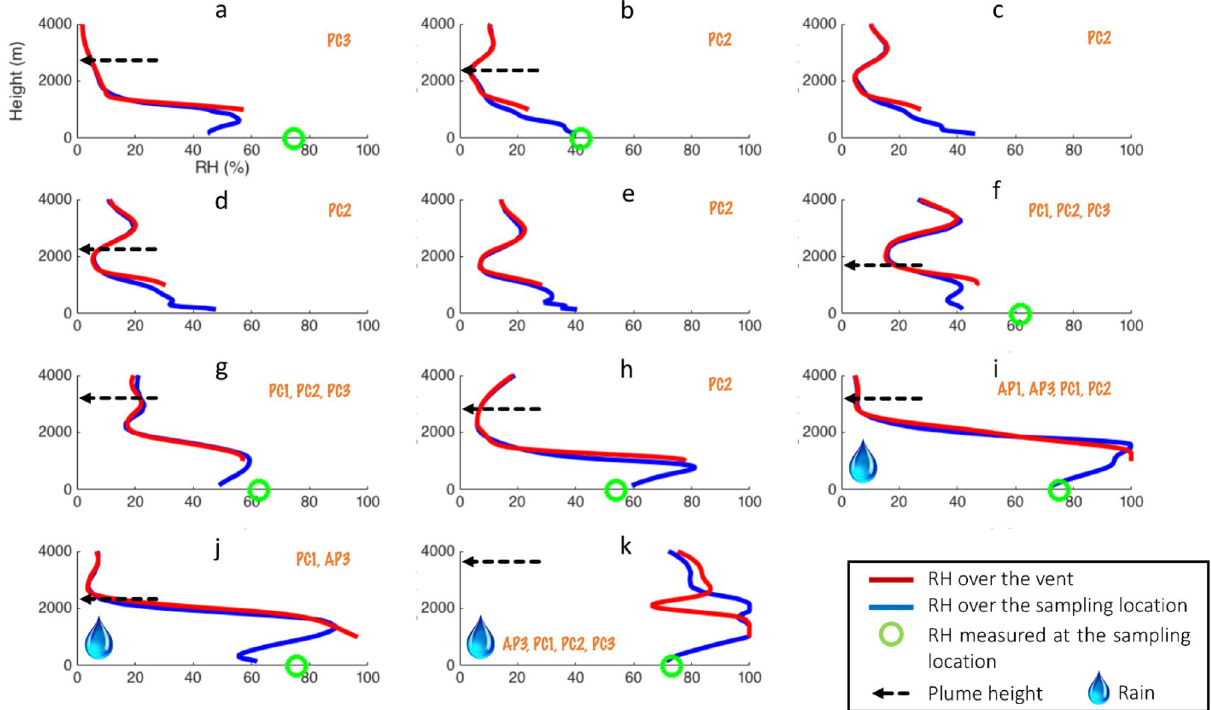
Figure 6. Modelled relative humidity profiles above the vent and above the sampling locations for all the eruptions obtained using the Weather Research and Forecasting (WRF) model. The green dot is the actual value measured using the portable meteorological station at the sampling location. The dotted arrow indicates the plume height associated with each eruption. All heights are shown above sea level. The raindrop indicates events characterized by rain fall. Identification label for all eruptions is shown on plots (a to k; Table